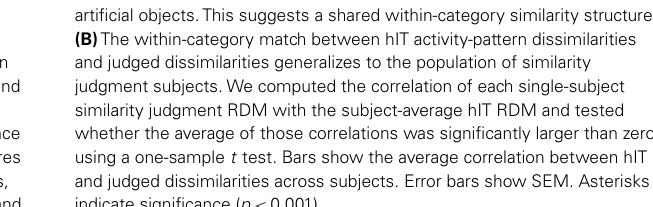
artificial objects.This suggests a shared within-category similarity structure. (B) The within-category match between hIT activity-pattern dissimilarities and judged dissimilarities generalizes to the population of similarity judgment subjects.We computed the correlation of each single-subject similarity judgment RDM with the subject-average hIT RDM and tested whether the average of those correlations was significantly larger than zero, using a one-sample t test. Bars show the average correlation between hIT and judged dissimilarities across subjects. Error bars show SEM. Asterisks indicate significance ( p <